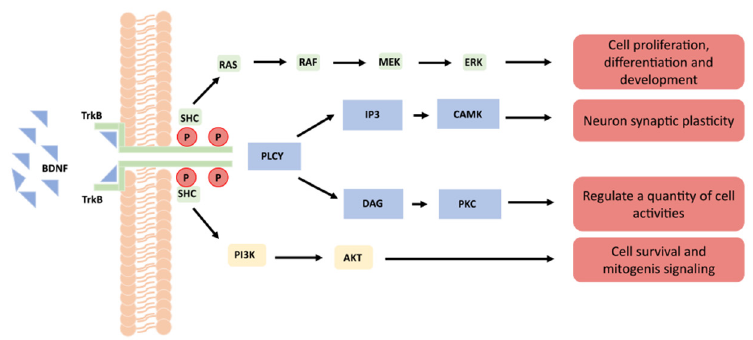
Figure 1. Schematic diagram of cell signal pathway after BDNF and TrkB